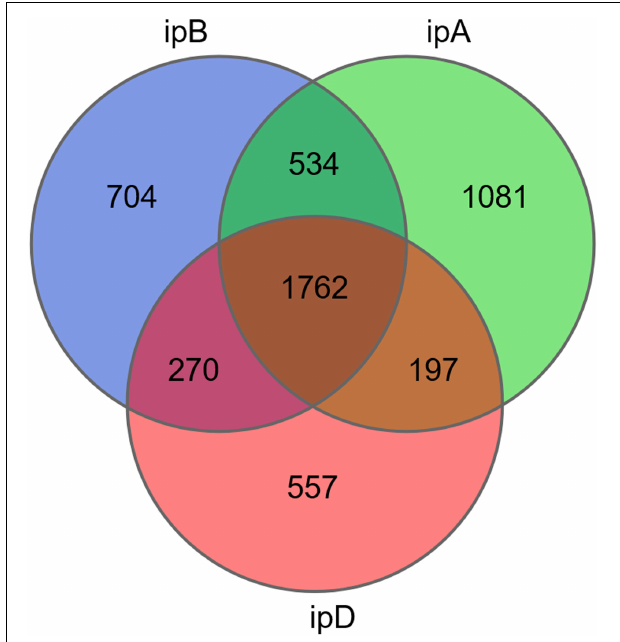
FIGURE 7 | Venn diagram of OTUs in the 3 groups. The different colored circles represent different groups.